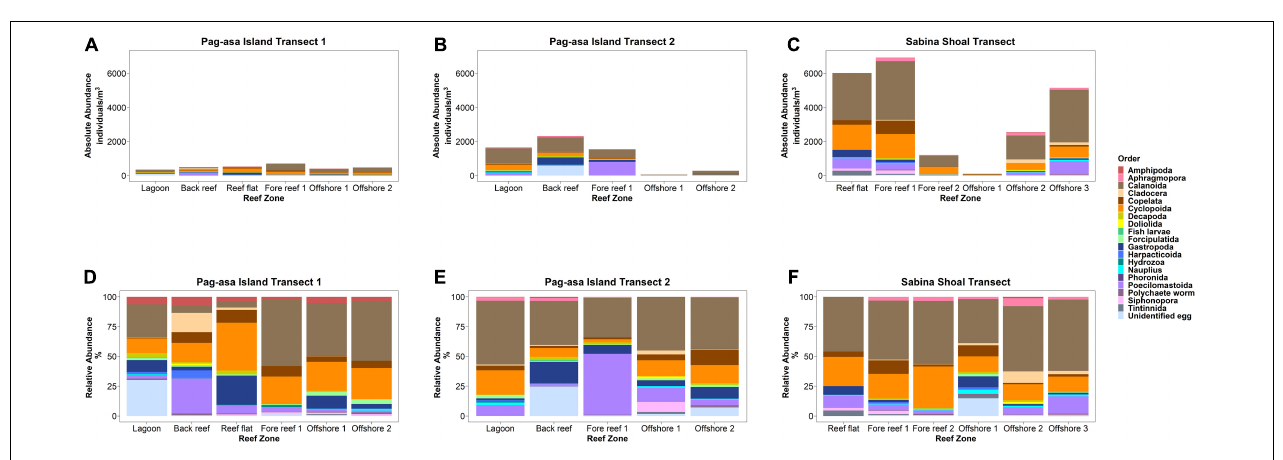
FIGURE 6 | Zooplankton absolute (A,B,C) and relative (D,E,F) abundances across the reef systems of Pag-asa Island and Sabina